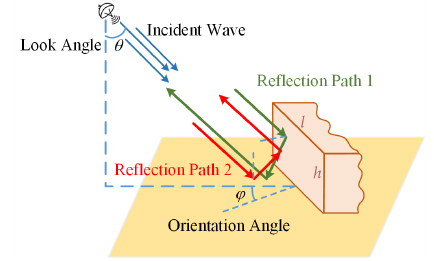
Figure 1. Dihedral scattering analysis model.